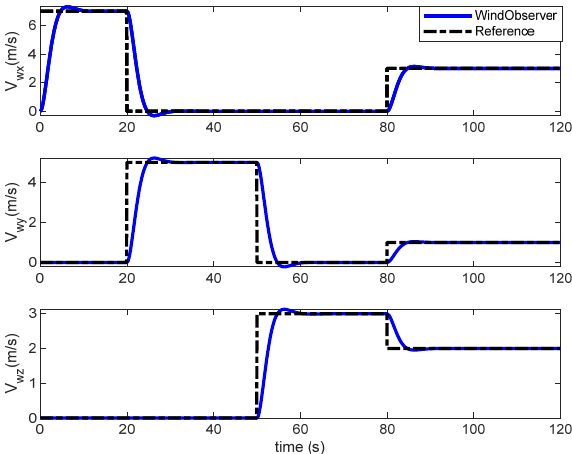
Figure 5. Tracking responses of Euler angles with and without wind compensation.